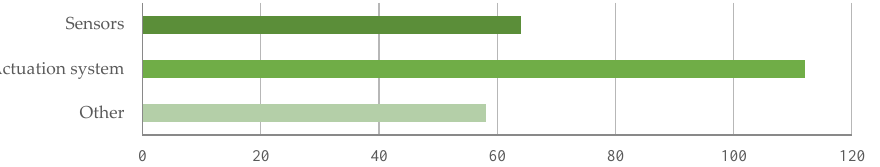
Figure 8. The distribution of exoskeletons by focus. About 52% of the revised publications have the actuation system as main focus and 30% concern sensors. The Others category includes jobs for which there is a significant part related to the actuation or sensors, but the main focus is different (design, kinematics, modeling, validation or signal